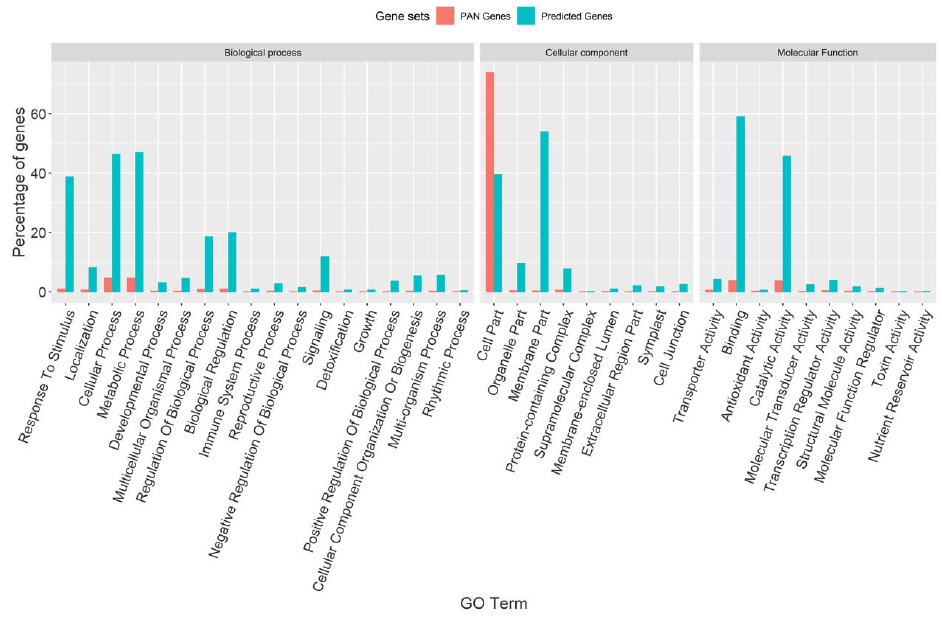
Figure 3. Functional annotation of the predicted genes in the non-reference contigs of the rice pan-genome. GO terms enriched at padj < 0.05 significance.